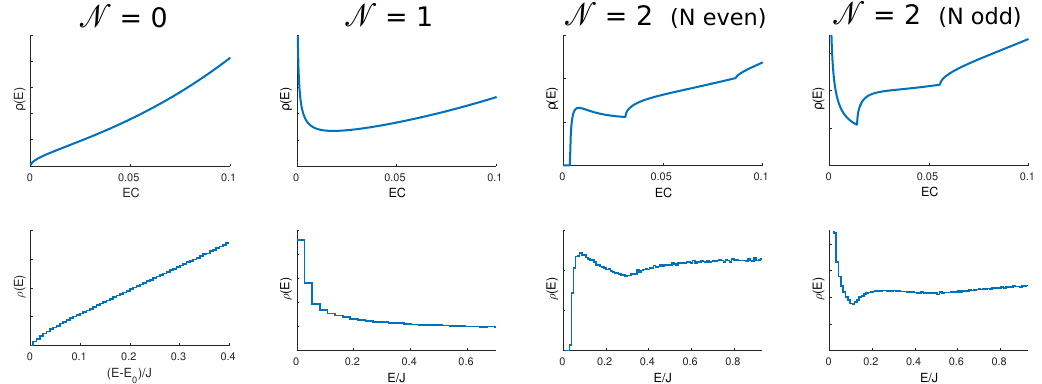
Figure 1 . Top: exact density of states of the Schwarzian theory near the ground state, for di(cid:11)erent amounts of supersymmetry. For the two N = 2 cases we chose ^ q = 3 and we omitted the (cid:14) ( E ) contribution to the spectrum. Bottom: the numerical density of states from exact diagonalization of (super) SYK with a four-fermion Hamiltonian. The Hilbert space dimensions used are respectively 2 16 ; 2 16 ; 2 18 ; 2 19 . The N = 0 case is an average using data from [11]. The other curves are for a single